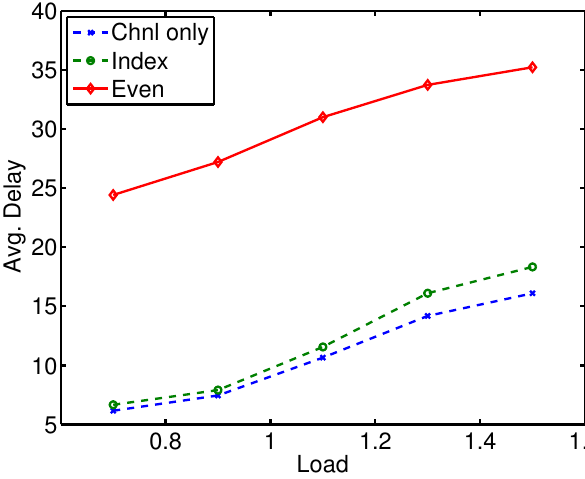
Figure 4. Traffic smoothing